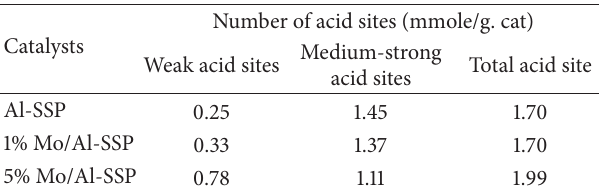
Table 3: The surface acidity of all catalysts from NH 3